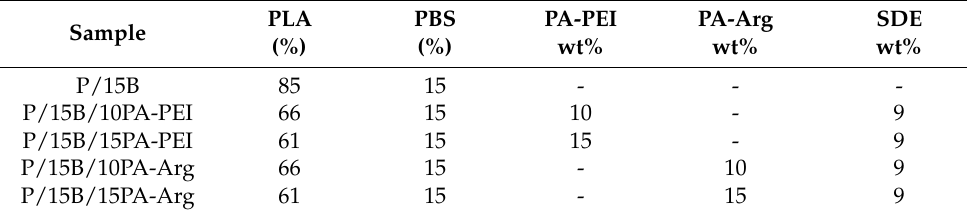
Figure 1. The preparation process of the flame-retardant P/15B-based composites. Table 1. Formulation of the resulting P/15B-based biocomposites.